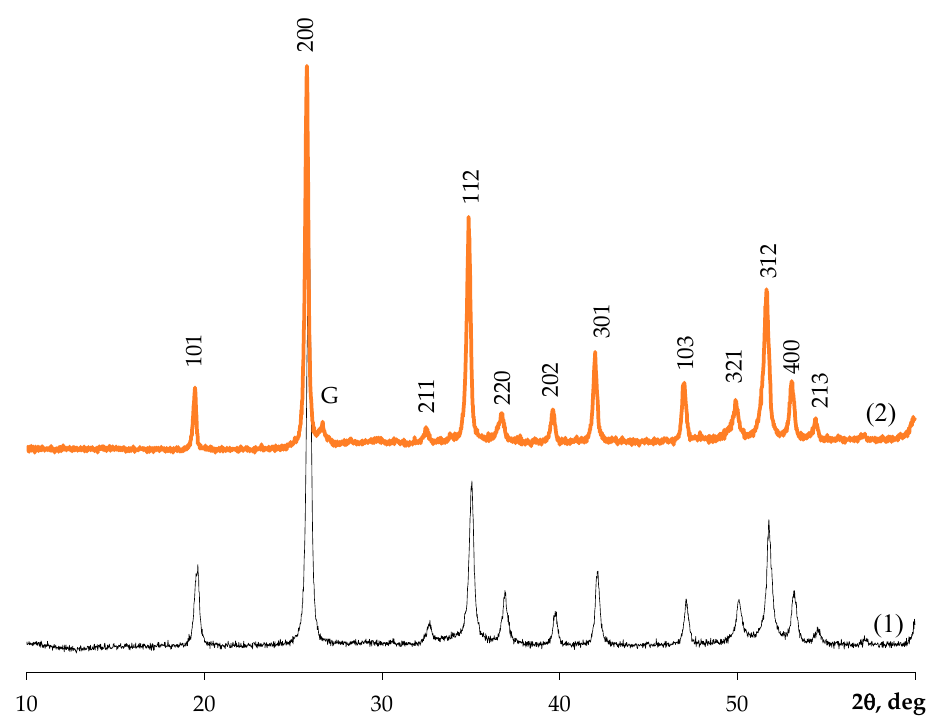
Figure 2. XRD data for YPO 4 :Gd powder after annealing at 900 °C (5 h) (1) and for the SPS ceramic (2). Symbol “G” marks the reflection from graphite.